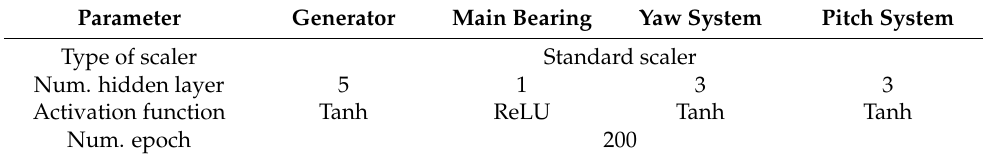
Table 5. Results of parameter selection of the neural network for each